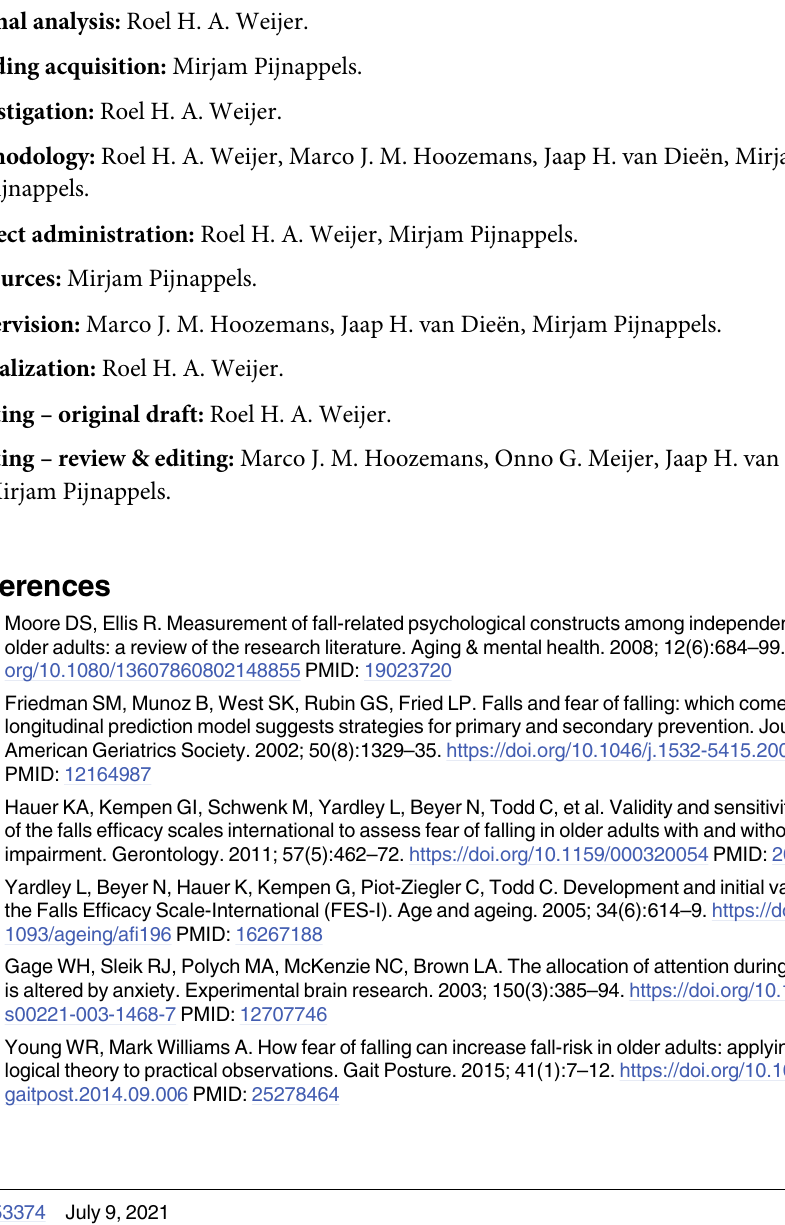
S4 Table. Relation between falling and concern about falling over long-term and short- term intervals in participants with and without a recent history of falling.